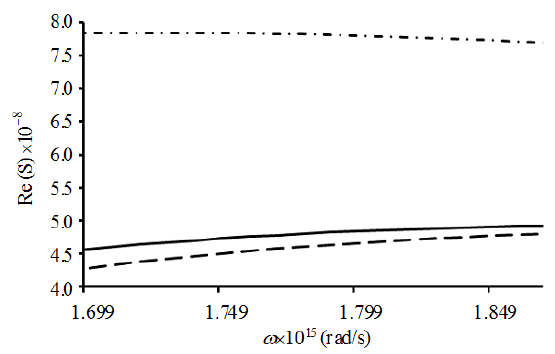
Fig. 2 Real part of the sensitivity for TE 0 versus frequency 7 =6.089 10    Siemens at different values of d . Dash line is when d = 75 nm, solid line is when d = 65 nm, and dash-dotted line is when d = 55 nm.